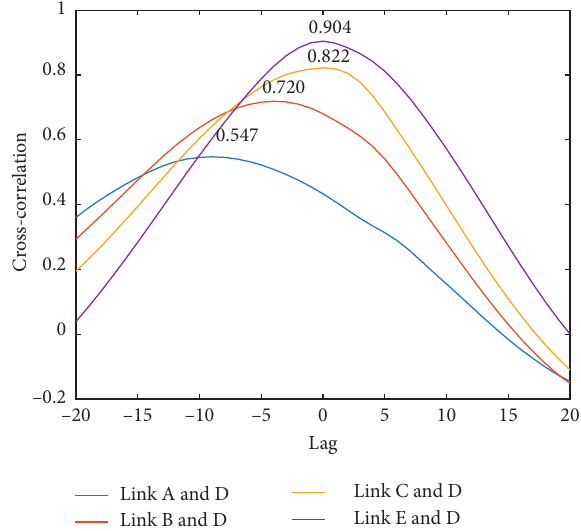
Figure 4: Cross-correlation functions of 5-minute travel time on link